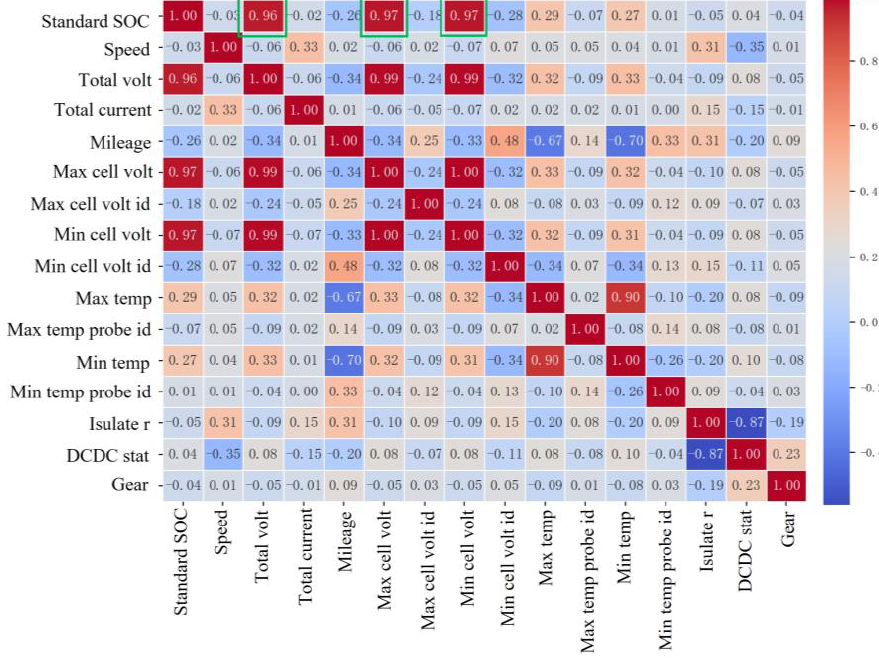
Figure 6. Heat map analysis of the correlation coefficient of the uncharged state.